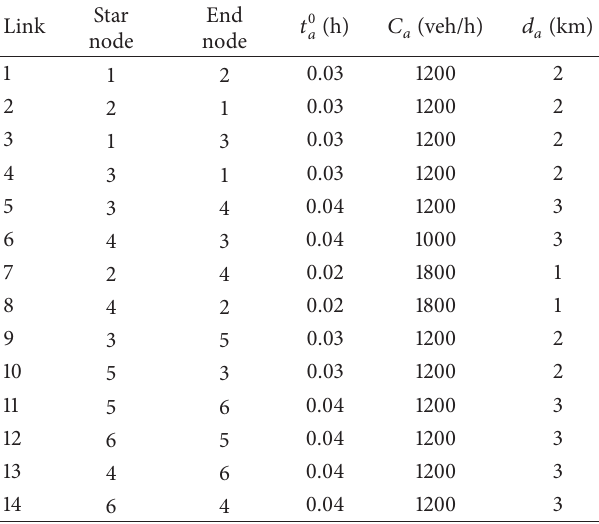
Table 1: Link free flow, capacity and length.